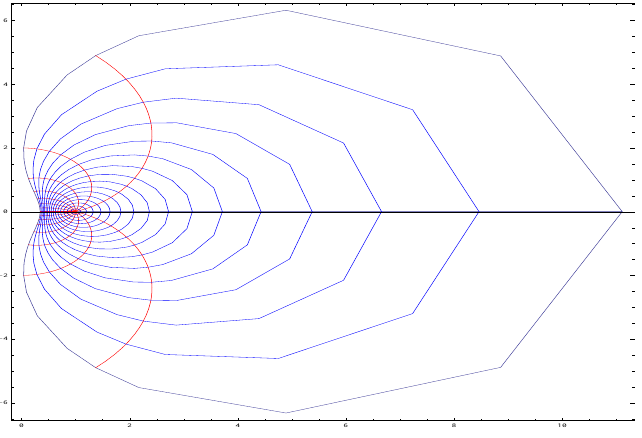
Figure 2. Mapping of | z | < 0.7 under Λ